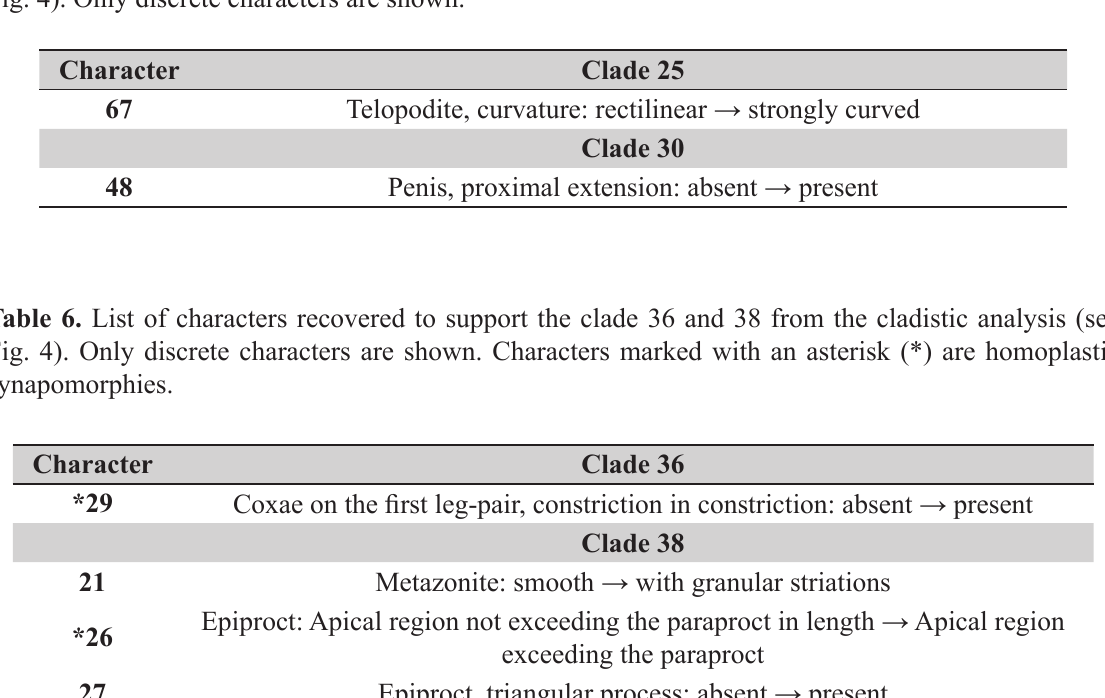
Table 5. List of characters recovered to support the clade 25 and 30 from the cladistic analysis (see Fig. 4). Only discrete characters are shown.